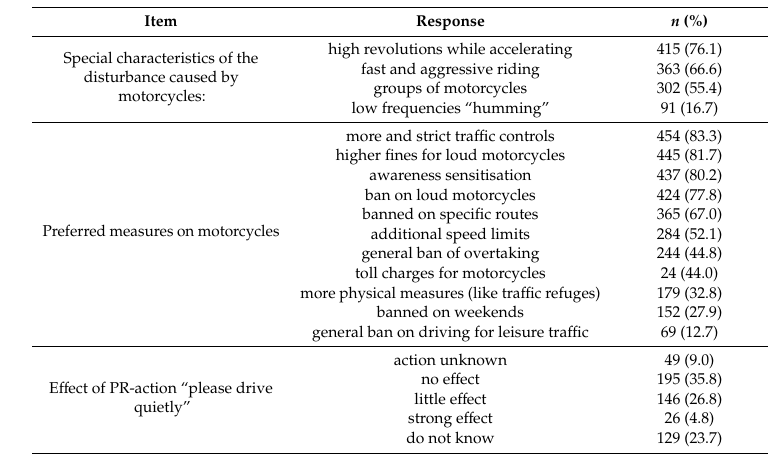
Table 5. Special characteristics of disturbance, preferred mitigation measures and e ff ectiveness of action “please drive quietly”.